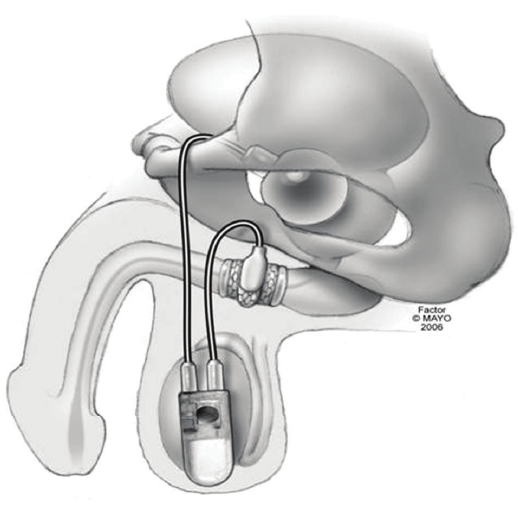
Figure 5: Graphical representation of the single-cu ff artificial urinary sphincter.